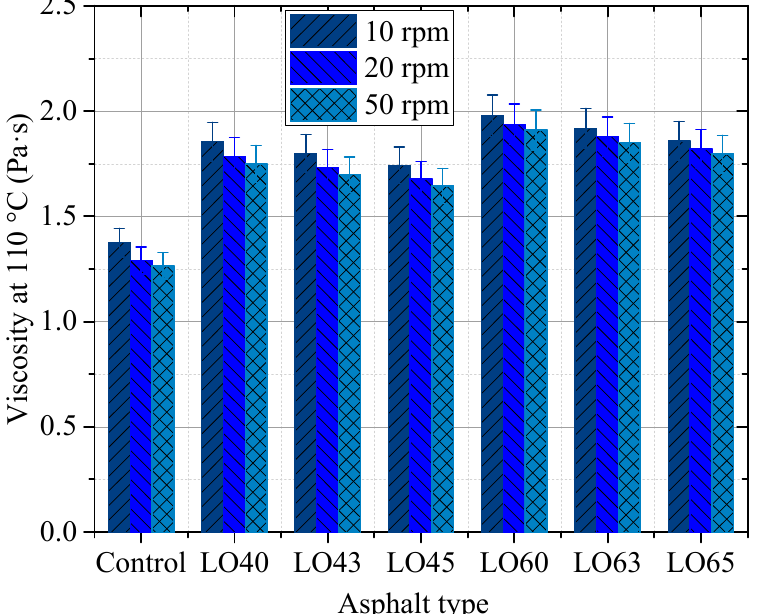
Figure 3. The viscosity of different asphalt types at 110 °C.